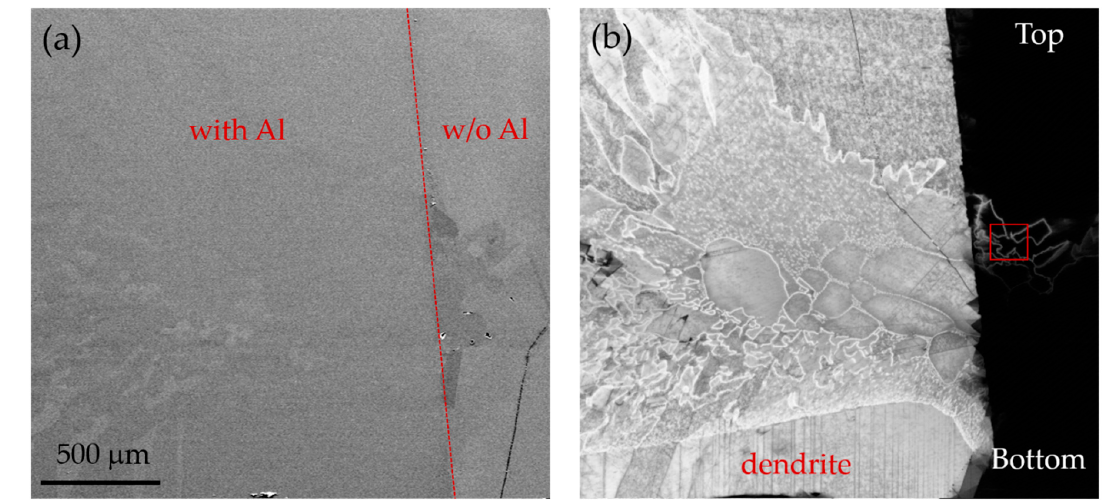
Figure 3. SE ( a ) and EBIC ( b ) images of a region containing the border of Al electrode. Bright contrast was found at grain boundaries (GBs) and intragranular defects.